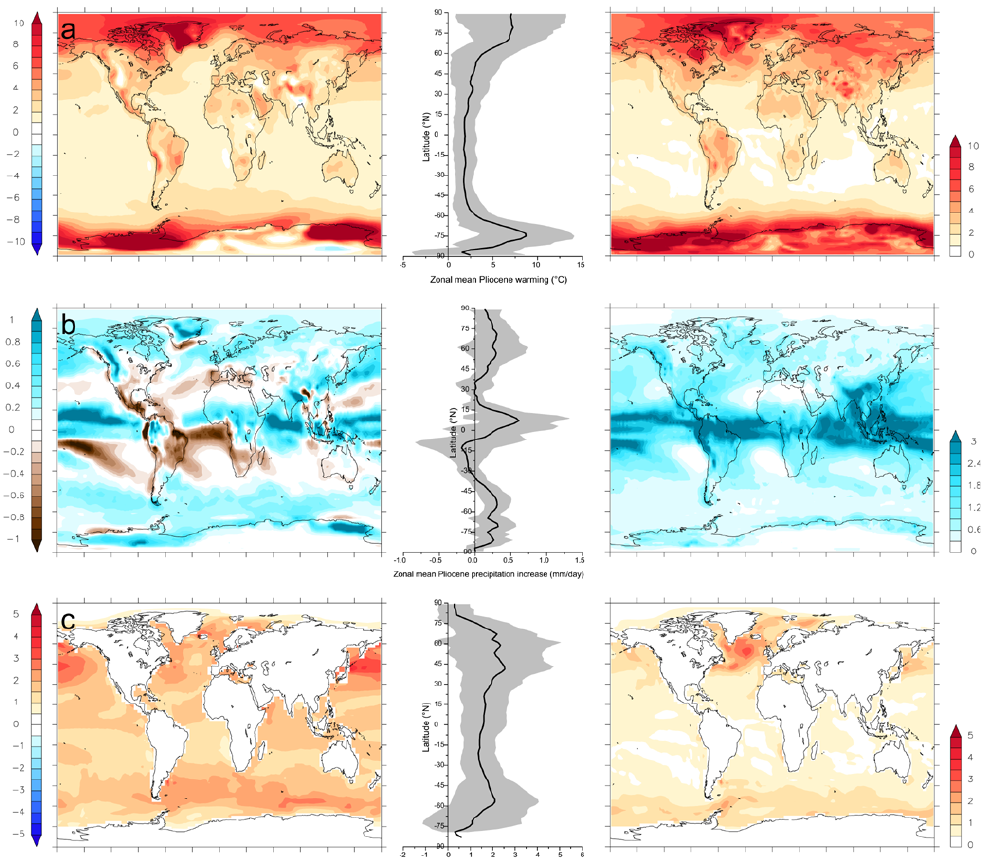
Fig. 3. Multi-model means, zonal means and model 2 σ from the Experiment 2 ensemble. (a) mean annual surface air temperature anomaly (Experiment 2 Pliocene minus pre-industrial control), (b) mean annual total precipitation rate anomaly (Experiment 2 Pliocene minus pre- industrial control) and (c) mean annual sea surface temperature anomaly (Experiment 2 Pliocene minus pre-industrial control). Shading around the zonal mean is the model 2 σ